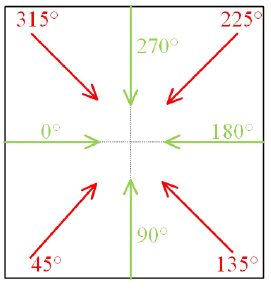
Figure 2. Gradient direction